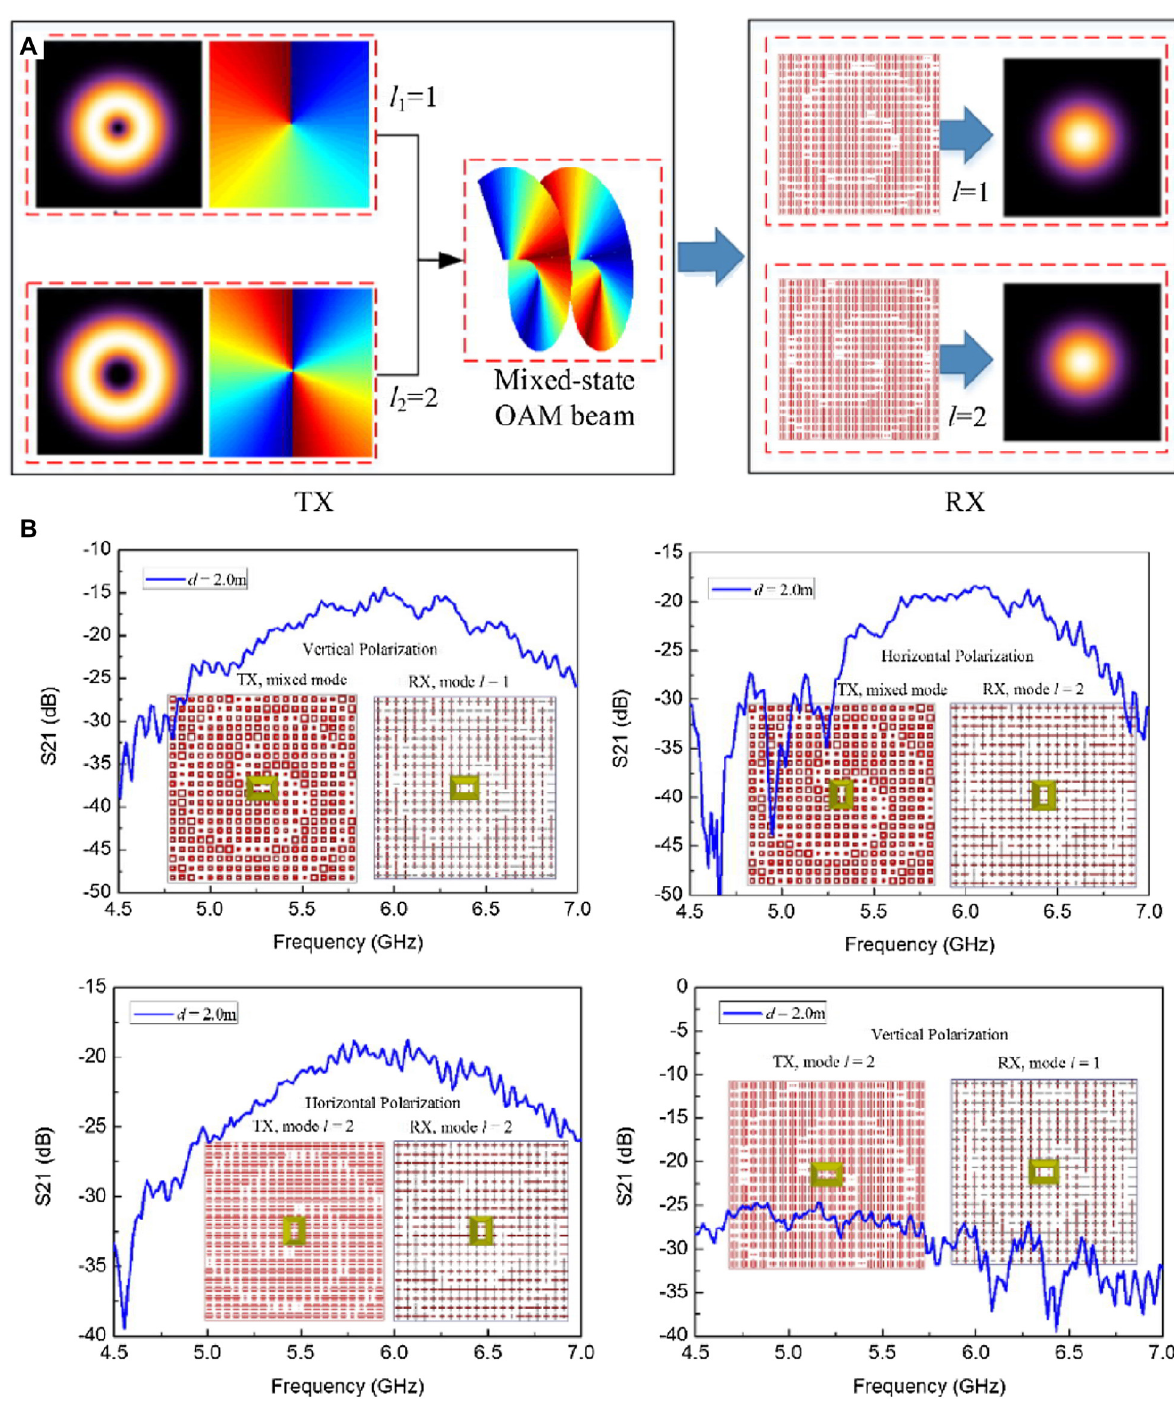
Figure 5: Metasufaces for information demodulation.